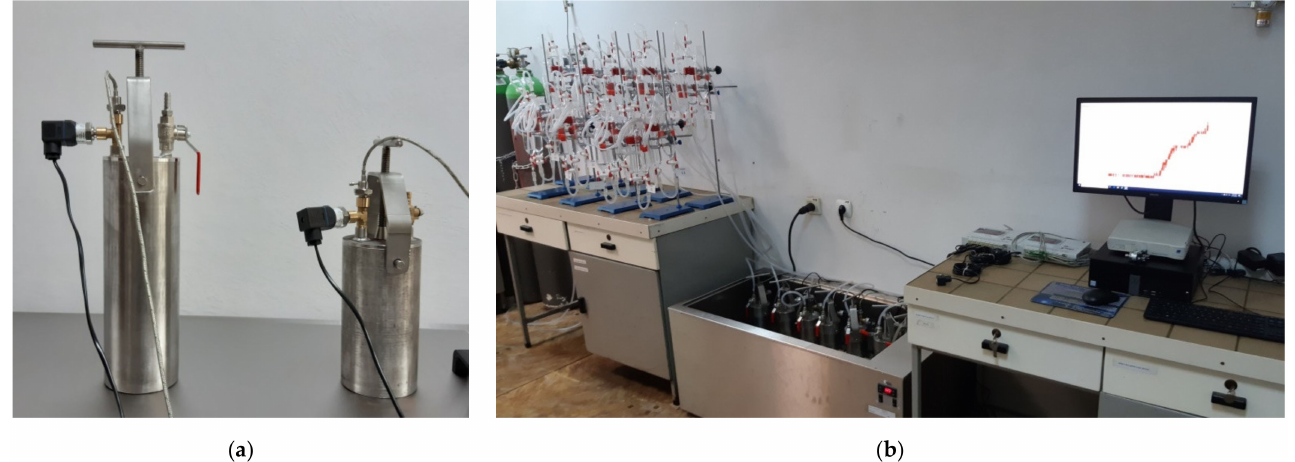
Figure 3. Central Mining Institute test stand for methane-bearing capacity identification by the USBM direct method: ( a ) Hermetically sealed steel containers with pressure and temperature sensors; ( b ) Central Mining Institute USBM dedicated test stand.